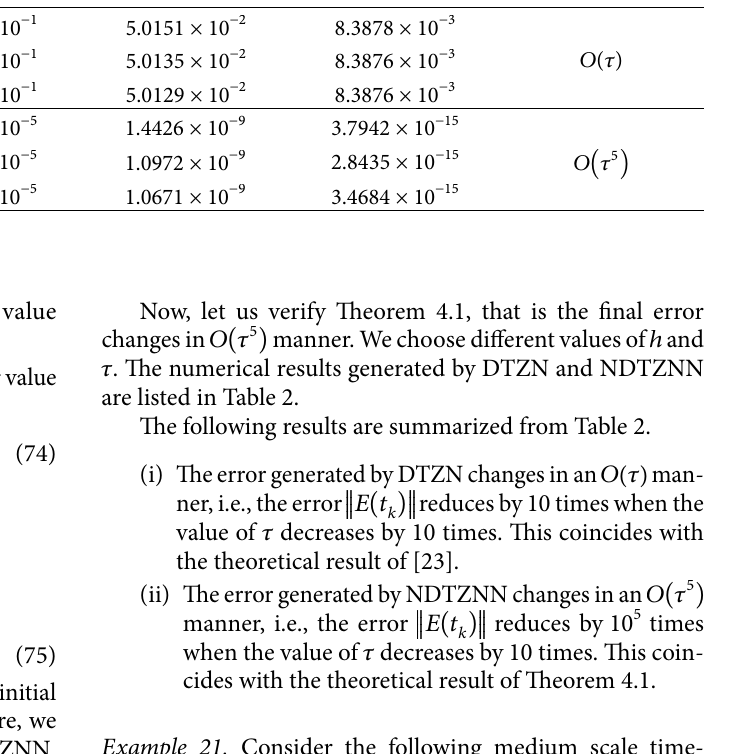
Table 2: generated by DTZN and NDTZNN using different values of ℎ and 𝜏 for Example 5.2. 󵄩󵄩󵄩󵄩𝐸(𝑡 990 )󵄩󵄩󵄩󵄩